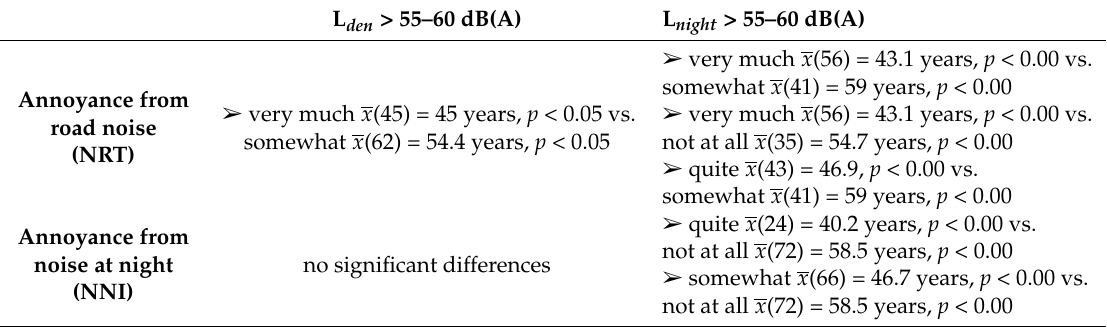
Table 7. Differences in mean age between groups reporting different levels of annoyance with road noise and night noise (from households exposed to >55–60 dB(A) L den and L night